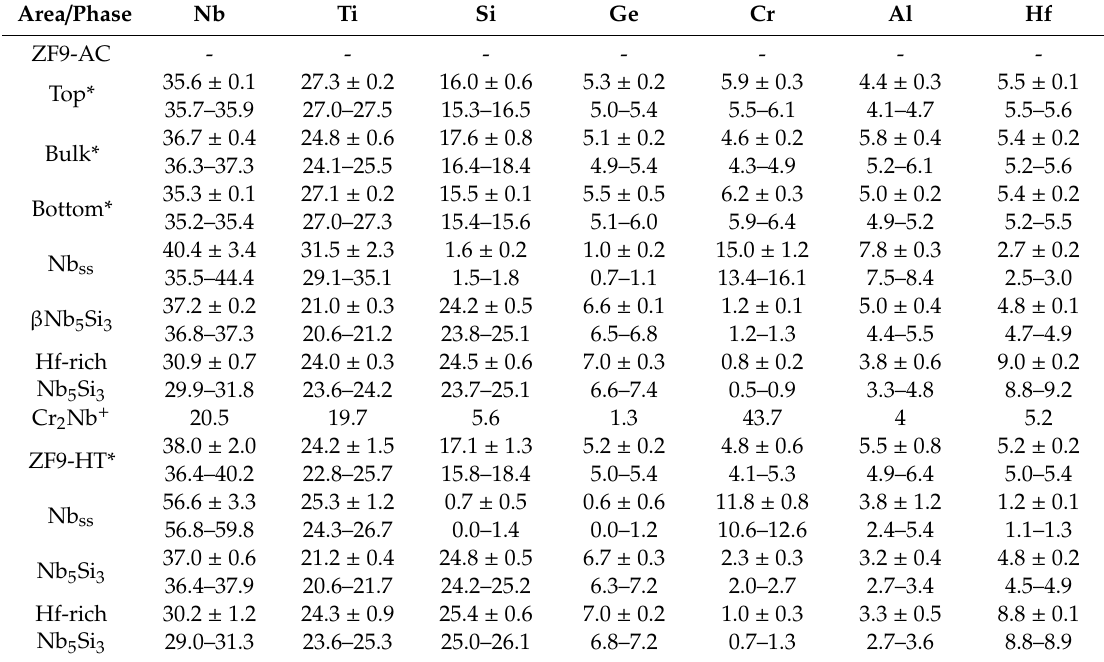
Table 3. Chemical analysis data (at.%) of as cast (AC) and heat treated (HT) alloy